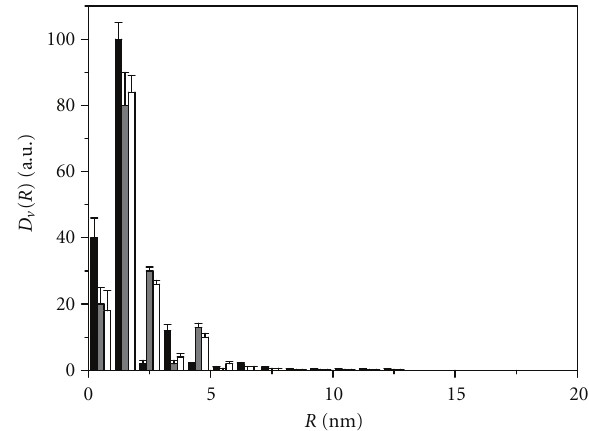
Figure 6: SAXS histogram of the particle size distribution in anatase samples obtained by hydrolysis of TIP in the presence of acetylacetone: black bars-initial sol after synthesis; grey bars- secondary sol obtained from dry initial sol after repulping in water; white bars-sol obtained from the secondary sol after centrifuging at 3000